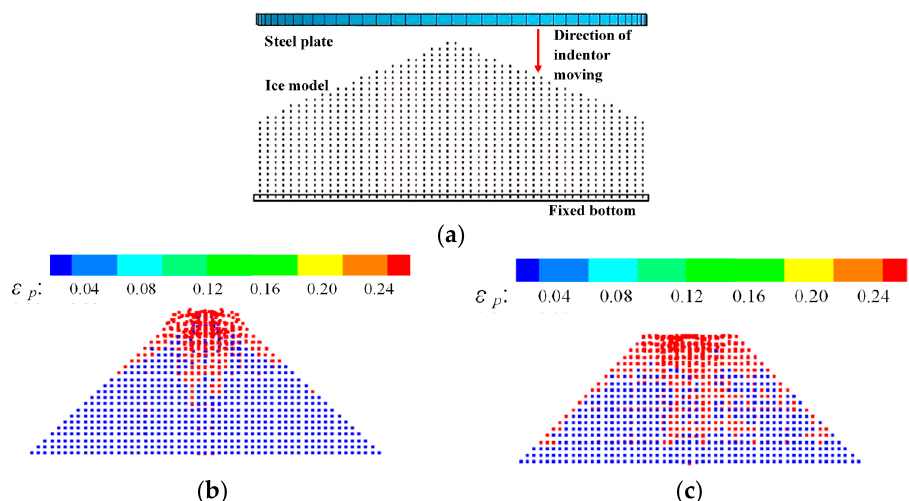
Figure 1. The compressive cone-shaped ice, where ( a ) is the present numerical models of the cone-shaped ice and the steel plate; and the brittle fracture of the ice cone in the numerical simulation at different time (compression speed v = 100 mm/s): ( b ) t = 0.04 s; and ( c ) t = 0.08 s (contours of plastic strain).